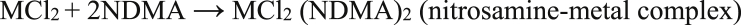
Nitrosamine-metal complex.